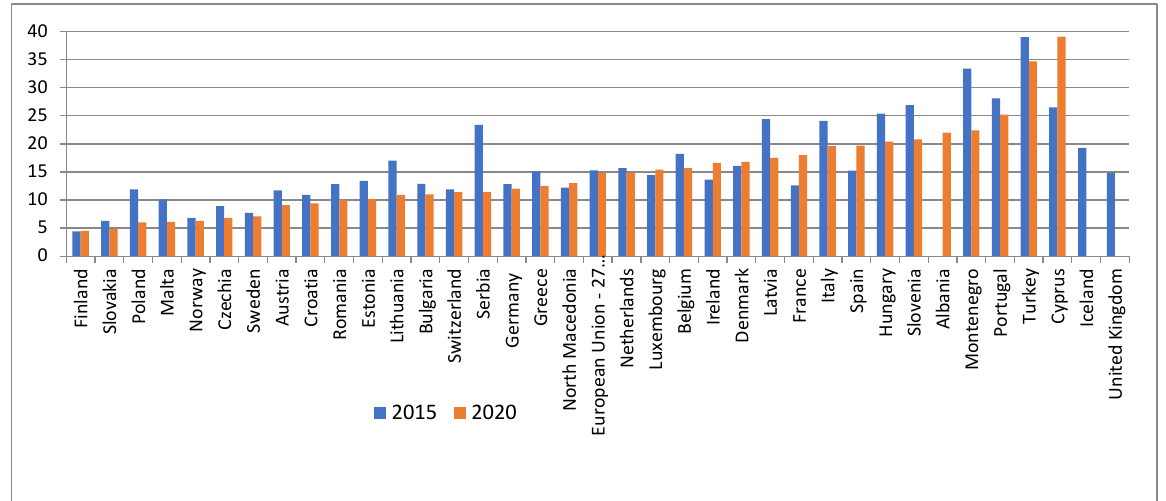
Figure 6. Percentage of the population living in a dwelling with a leaking roof, damp walls, floors or foundation or rot in window frames or the floor in 2015 and 2020. Source: own preparation based on the Eurostat database [47].